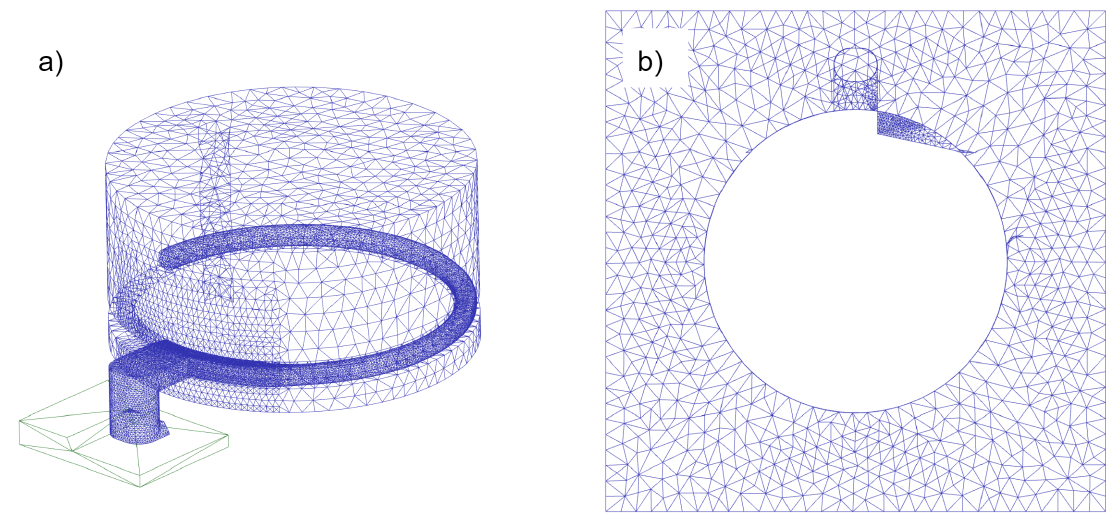
Figure 6. The meshes used for model 1. The meshes are refined in the plastic zone where the strain rates are at the highest. ( a ) the wheel and the feedstock material; ( b ) the